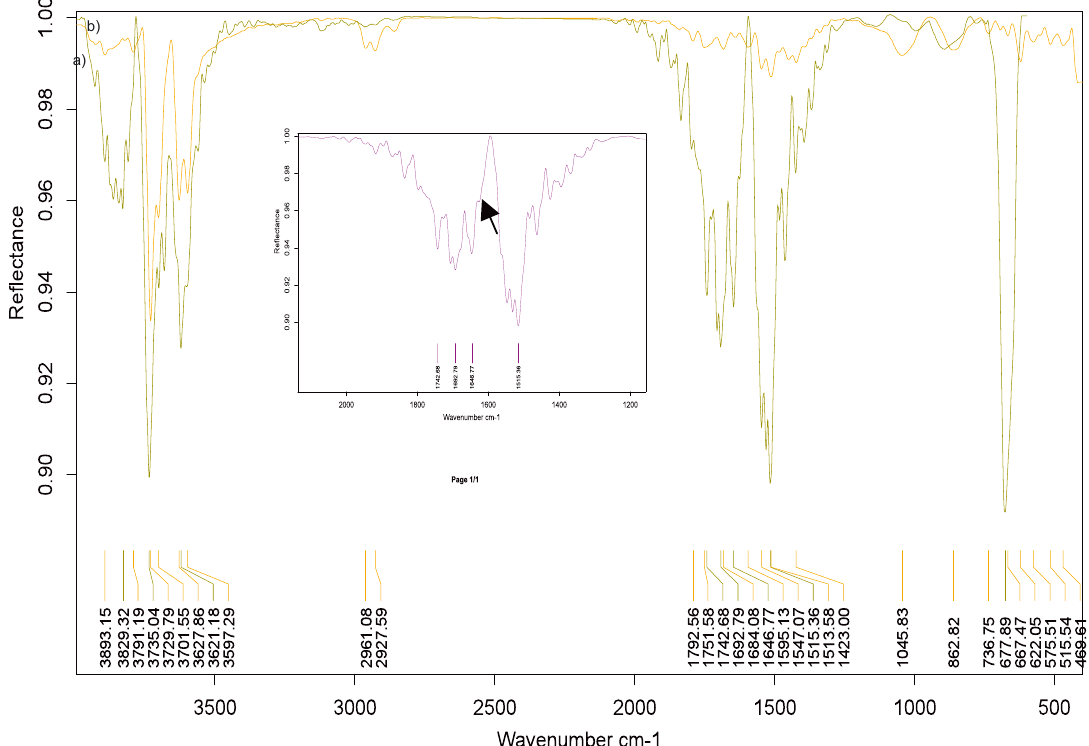
Figure 7. FTIR spectra for sample a) 321____ (and inset), and sample b) 204___ (Romanian amber samples)